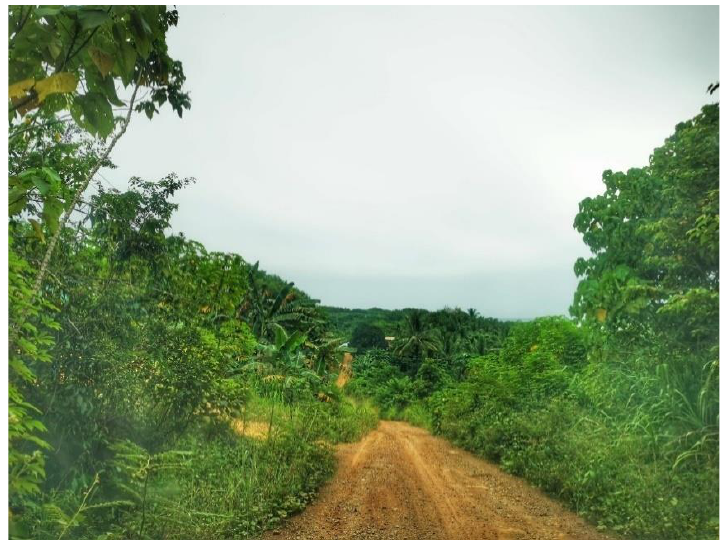
Figure 1. Entry route to the study